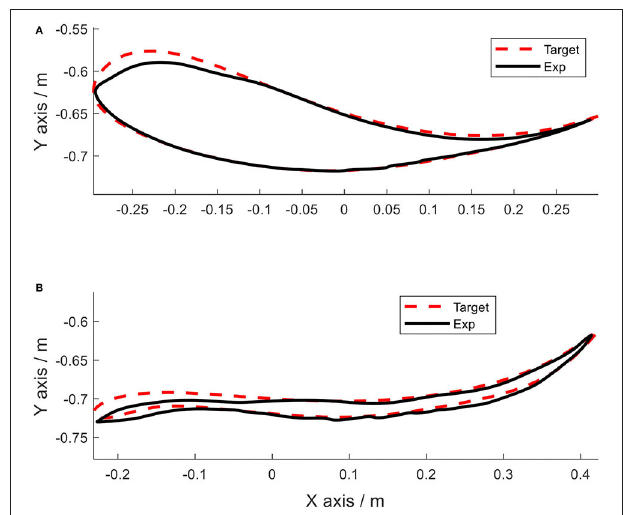
FIGURE 11 | Foot trajectories. (A) Ankle and (B)